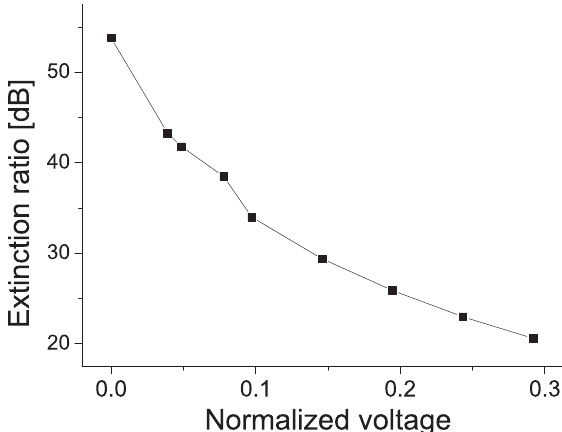
Figure 4. Extinction ratio controlled by a sub-MZI [12]. Parasitic optical phase modulation due to imbalance in induced phases on the two arms in the main MZI also causes generation of undesired high order sidebands. Such imbalance can be described by a chirp parameter [1]. The second order sideband genera- tion was mainly due to the parasitic optical phase modulation associated with the chirp parameter α , while the third order components are due to intrinsic nonlinearity of the MZMs. As described above, the chirp parameter α can be largely suppressed by using a dual-electrode MZM [10].